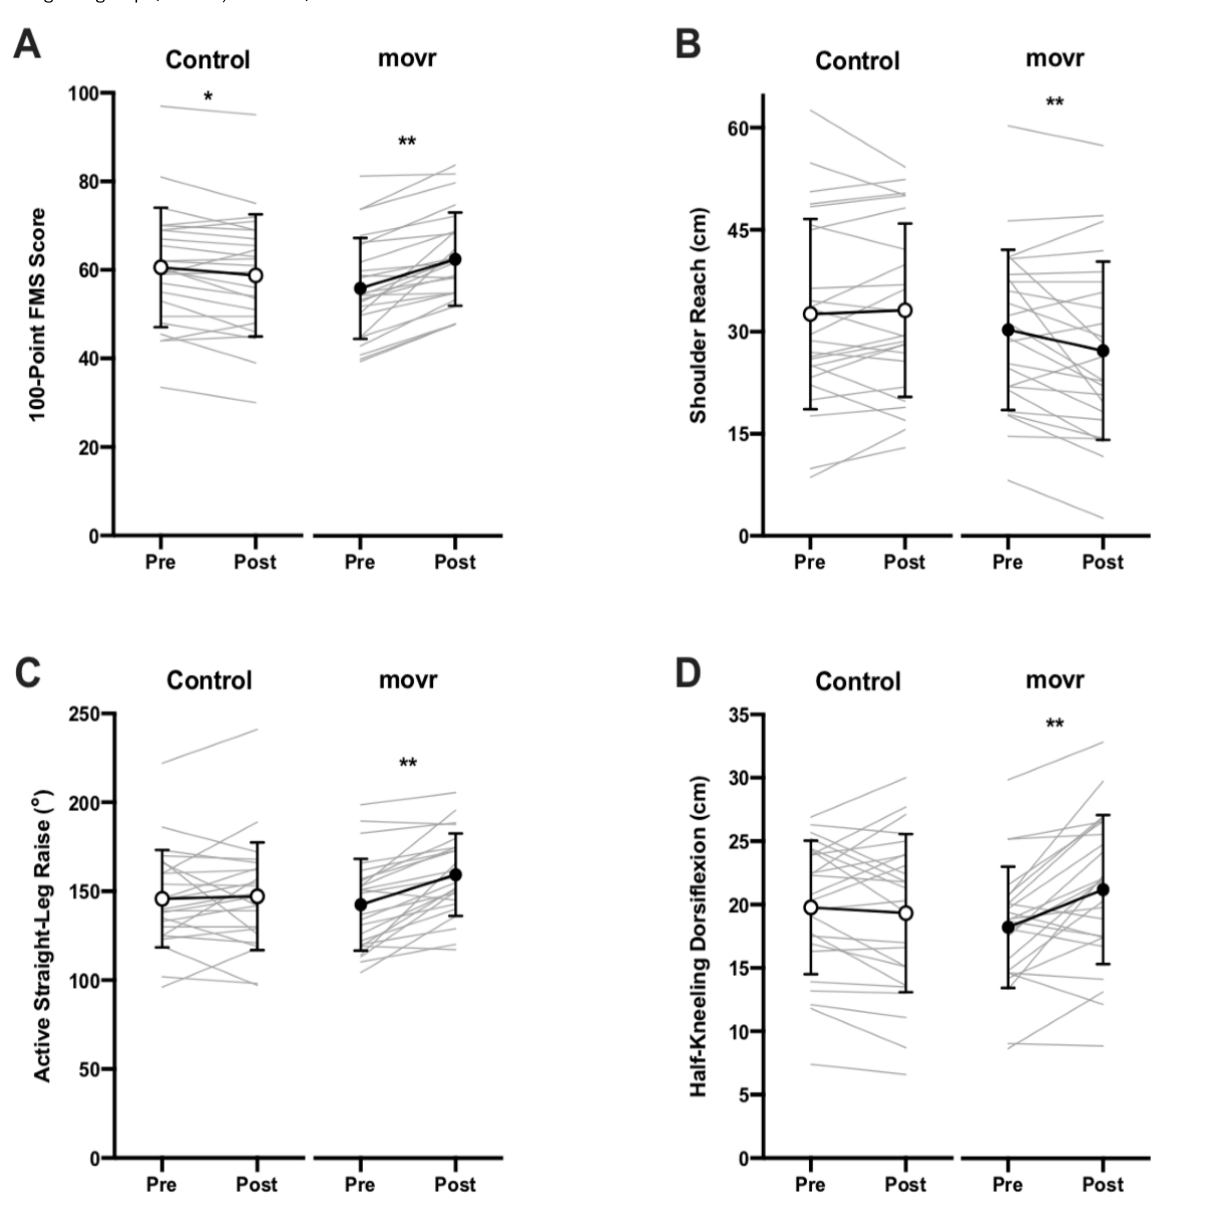
Figure 1. Measurements of (A) 100-point Functional Movement Screen, (B) shoulder reach, (C) active straight leg raise, and (D) half-kneeling dorsiflexion before (pre) and after (post) the 8-week intervention period. Circles with black connecting lines represent sample means with SD error bars, whereas gray lines represent individual participant data points. Asterisks indicate significant differences between pre- and postintervention values within a given group (* P <.05; ** P <.01). FMS: Functional Movement